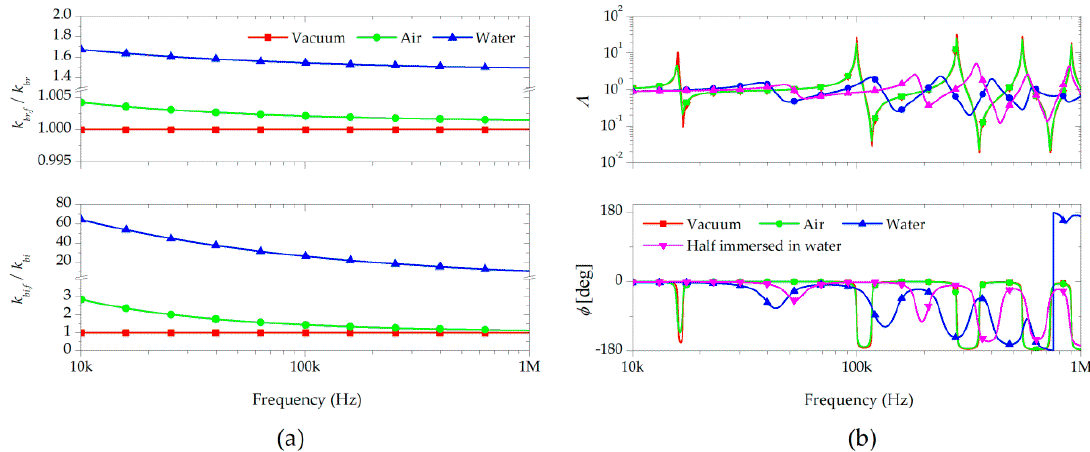
Figure 3. ( a ) Real part (top) and imaginary part (bottom) of the wavenumber ratio of a fluid to vacuum for vibrations of the cantilever in vacuum, air, and water; ( b ) Amplitude (top) and phase (bottom) of the predicted transfer functions of the micro-cantilevers fully immersed in vacuum, air, and water, and half-immersed in water.